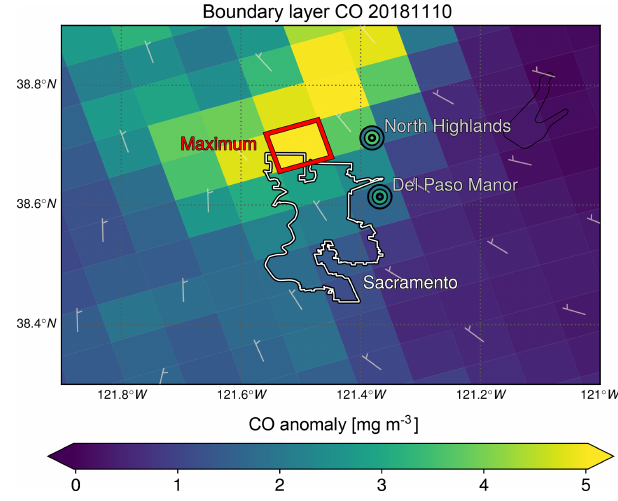
Figure 11. Boundary layer concentration anomalies of Sacramento and its environs determined from TROPOMI CO total column mea- surements and boundary layer heights from the ECMWF ERA5 reanalysis. Highlighted are the satellite scene with the maximal city area value (5 . 42mgCOm − 3 [3 . 41–6 . 00; 1 σ ], red) and the lo- cation of the AQMIS sites in North Highlands and at Del Paso Manor (black). The anomalies based on the maximum values of the ground-based sites (3 . 60 and 3 . 00mgCOm − 3 ) are colour-coded in the inner circle at the site location; the anomalies based on the daily averages (1 . 93mgCOm − 3 each) are colour-coded in the outer cir-